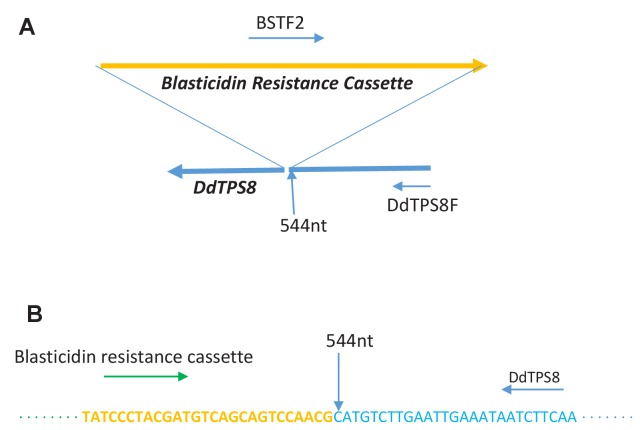
Verification of DdTPS8 insertion mutant.